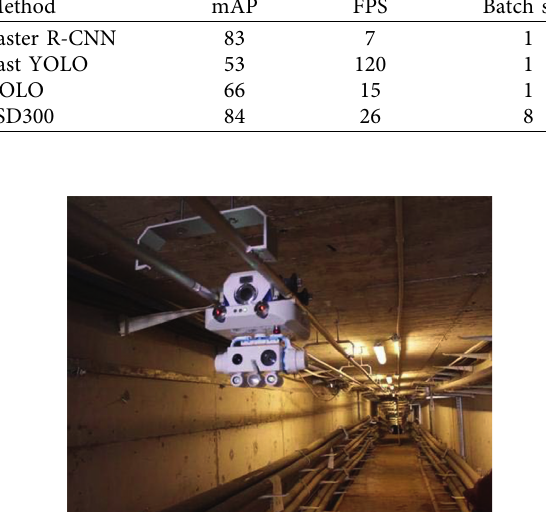
Figure 9: Tunnel patrol